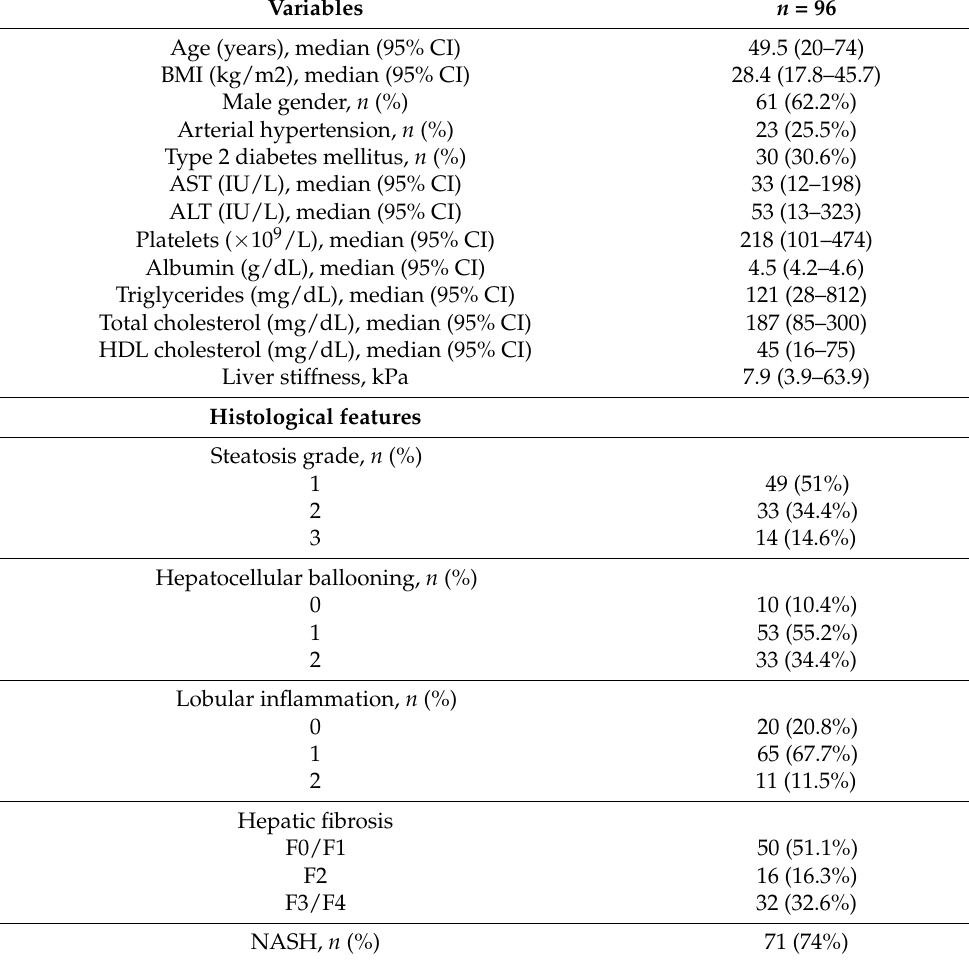
Table 1. Clinical, biochemical, and histological characteristics of the study